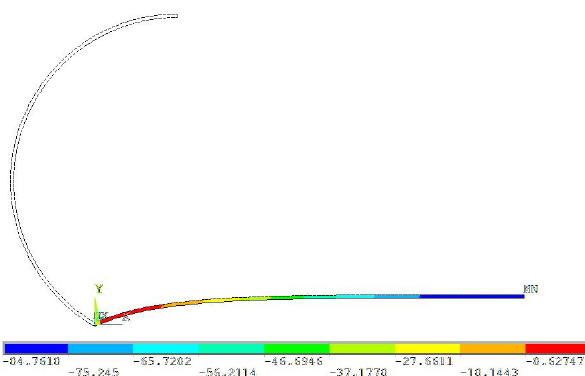
Figure 10: Influence of corrugation amplitude on force-stretch dia- grams